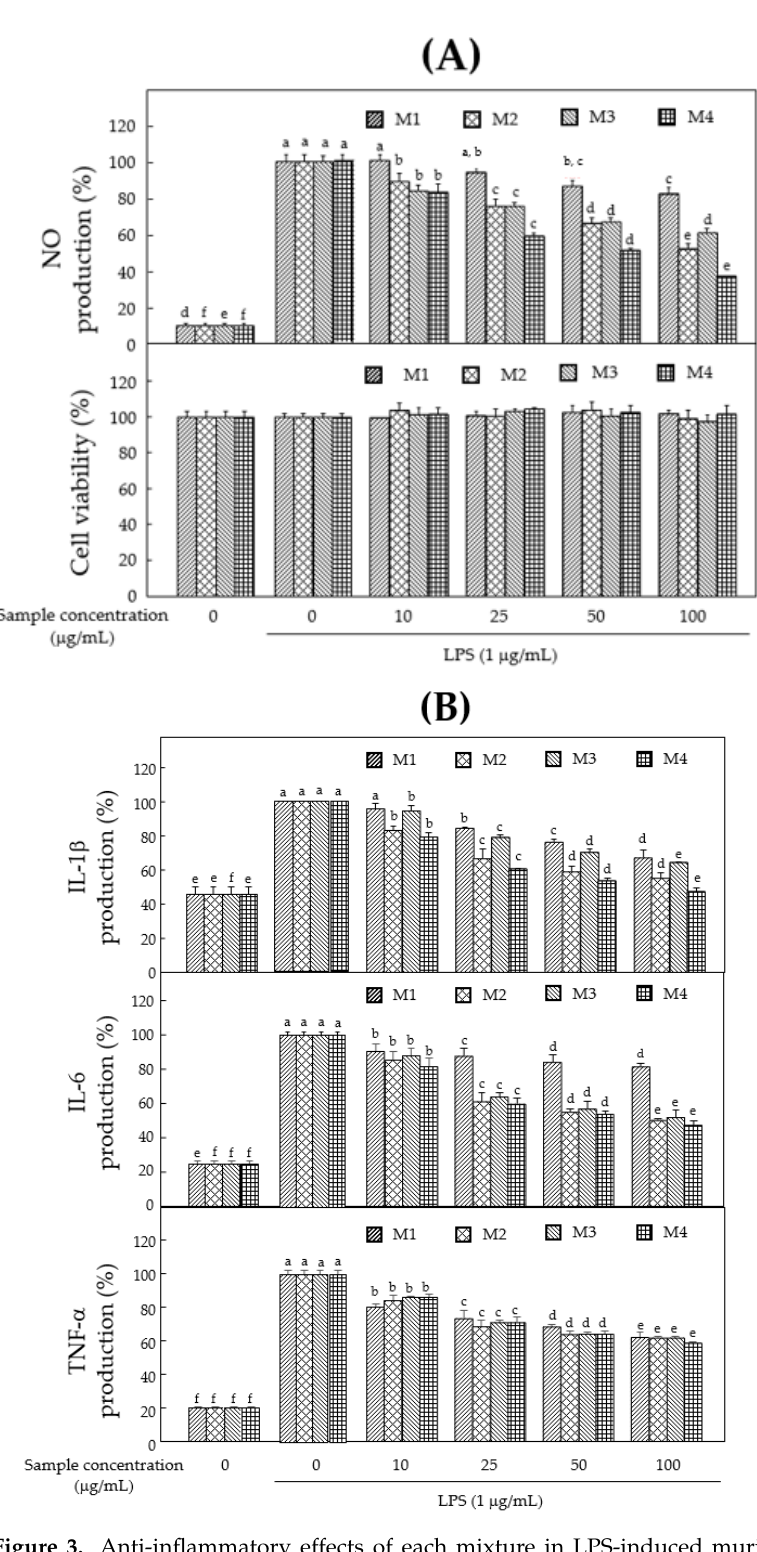
Figure 3. Anti-inflammatory effects of each mixture in LPS-induced murine macrophage cells. ( A ) NO production and cytotoxicity. ( B ) Generation of proinflammatory cytokines, IL-1 β , IL-6 and TNF- α in LPS-stimulated RAW 264.7 cells. Data are expressed as the means ± SD ( n = 3) of three individual experiments. Different letters of p -value < 0.05 were considered statistically